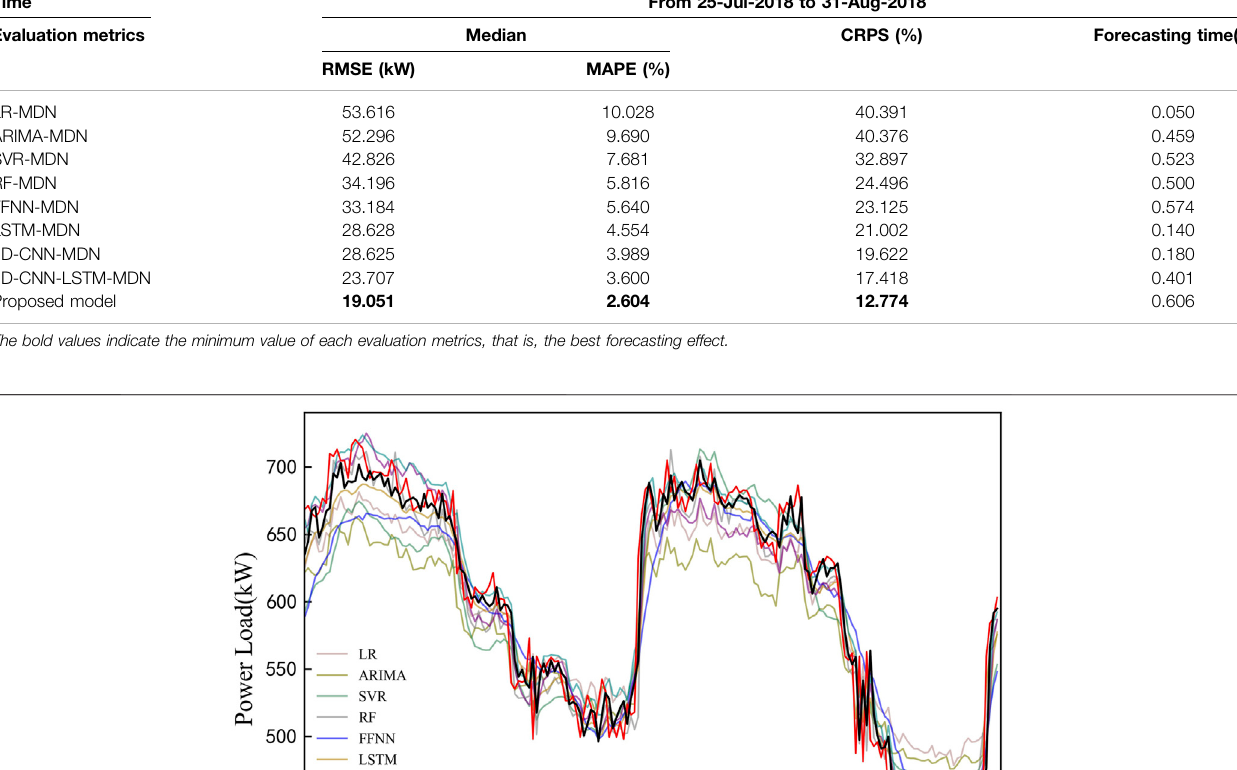
TABLE 4 | Load forecasting evaluation on the testing set. Time From 25-Jul-2018 to 31-Aug-2018 Evaluation metrics